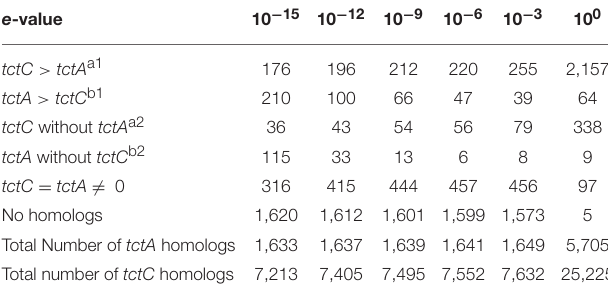
TABLE 5 | Number of genomes showing different patterns in terms of numbers of tctC and tctA homologs, using different e -values as